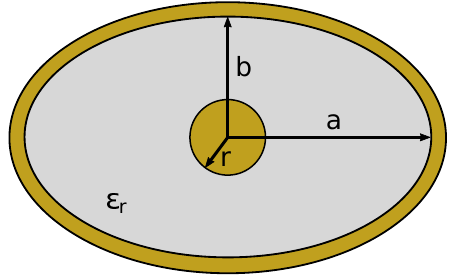
Figure 6. Cross-section of an elliptical coax transmission line.